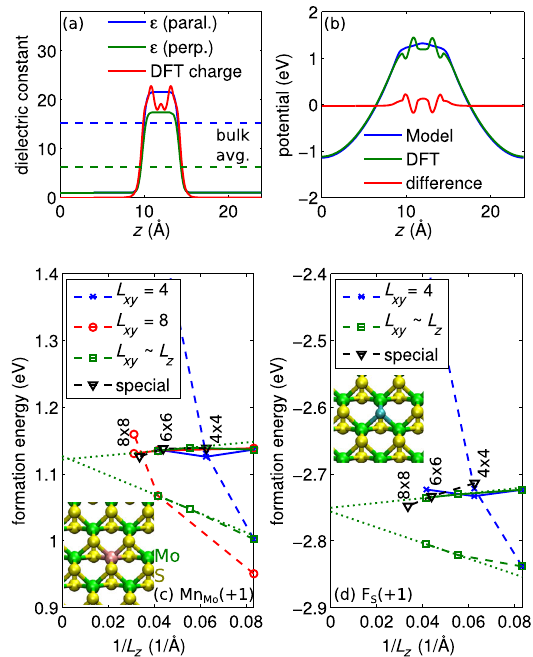
3. (a) Model dielectric constant profile for MoS 2 and comparison to plane-averaged charge density from DFT. Dotted horizontal lines denote the macroscopic dielectric constant of bulk 2H-MoS 2 . (b) Model and DFT potentials, and their differ- ðþ 1 Þ defect. (c, d) Uncorrected (dashed lines) ence for the Mn Mo and corrected (solid lines) formation energies for Mn ðþ 1 Þ (d) defects as a function of the inverse supercell (c) and F S size in the z direction L − 1 z . Extrapolations to infinitely large supercells and formation energies using special vacuums (cf. Table I) are also shown.